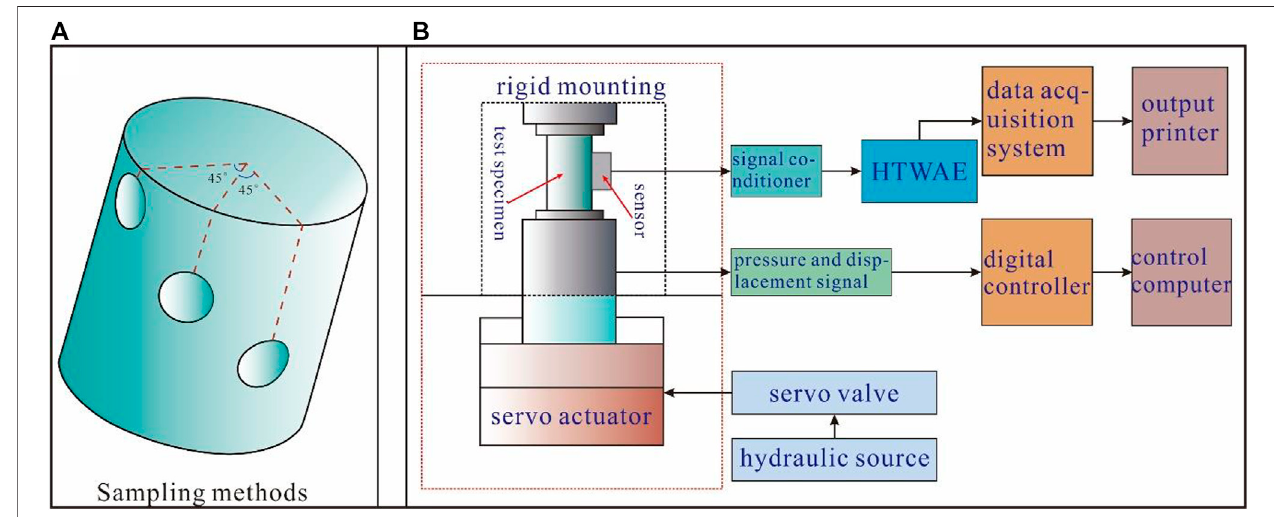
FIGURE 2 | Rock acoustic emission testing experimental system. (A) . Sampling methods; (B) . Experiment process.